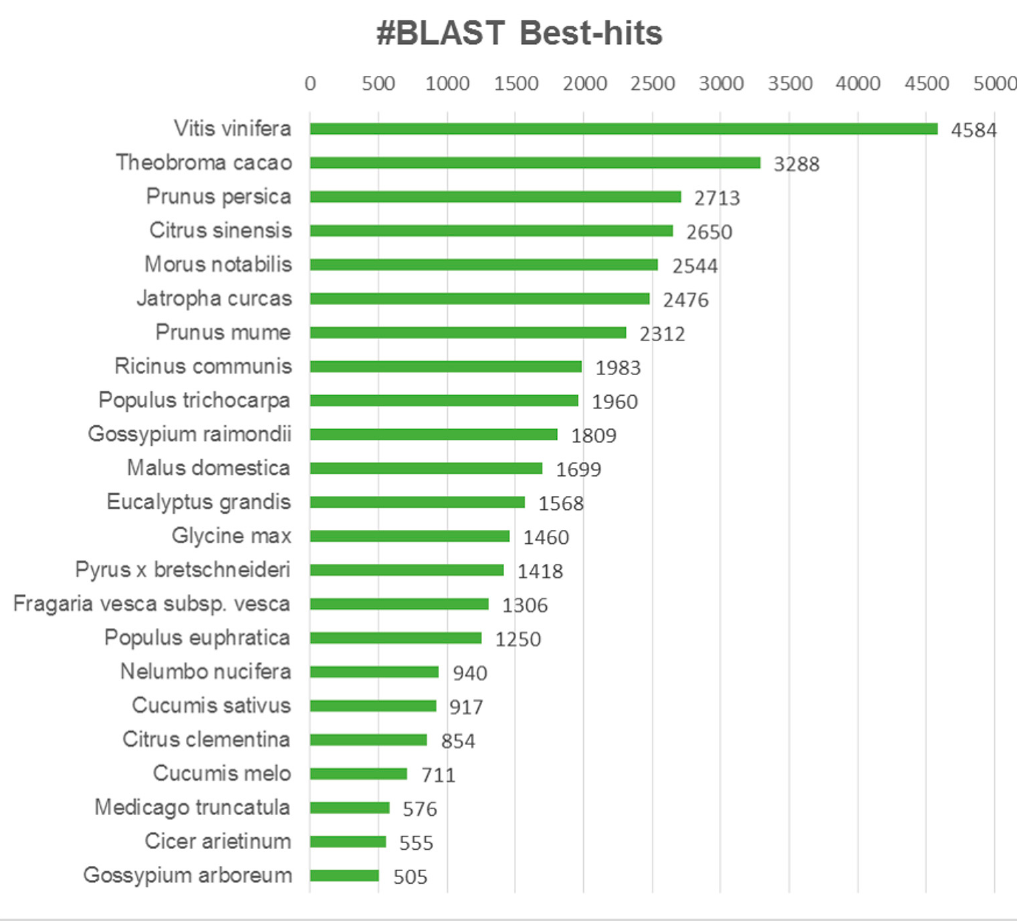
Figure 2. Blast top hits by species. The most representative species with a minimum of 500 hits are represented.